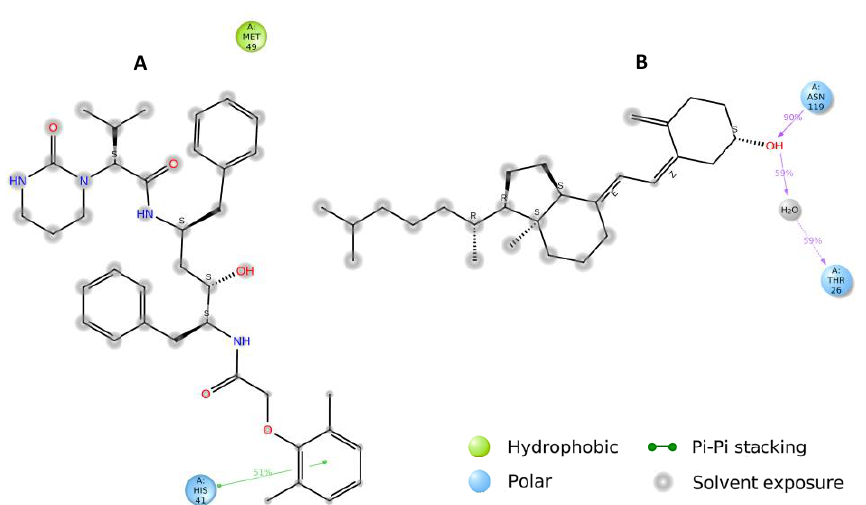
Figure 3. A schematic of detailed ligand atom interactions with the protein residues. Interactions that occur more than 30.0% of the simulation time in the selected trajectory (0.00 through 100.00 nsec), are shown. ( A ) Lopinavir ( B ) 25-hydroxy Vitamin D.